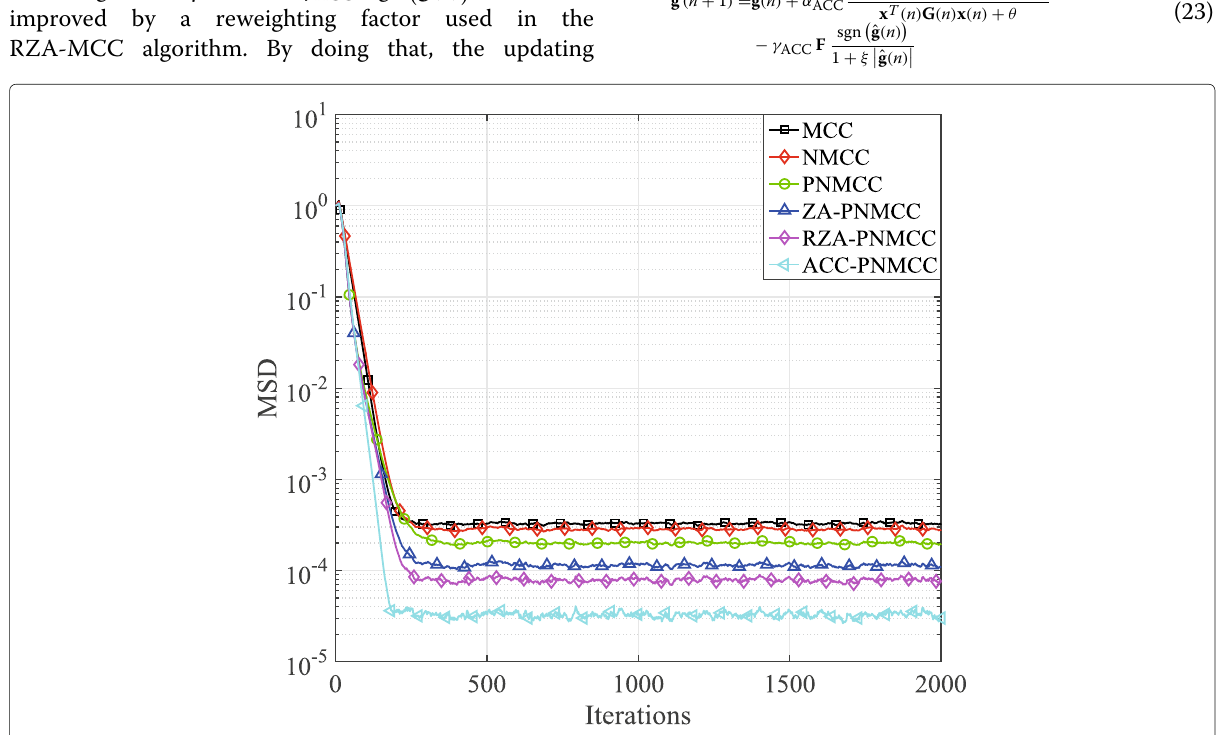
Fig. 4 The MSD performance of the proposed ACC-PNMCC algorithm with K =